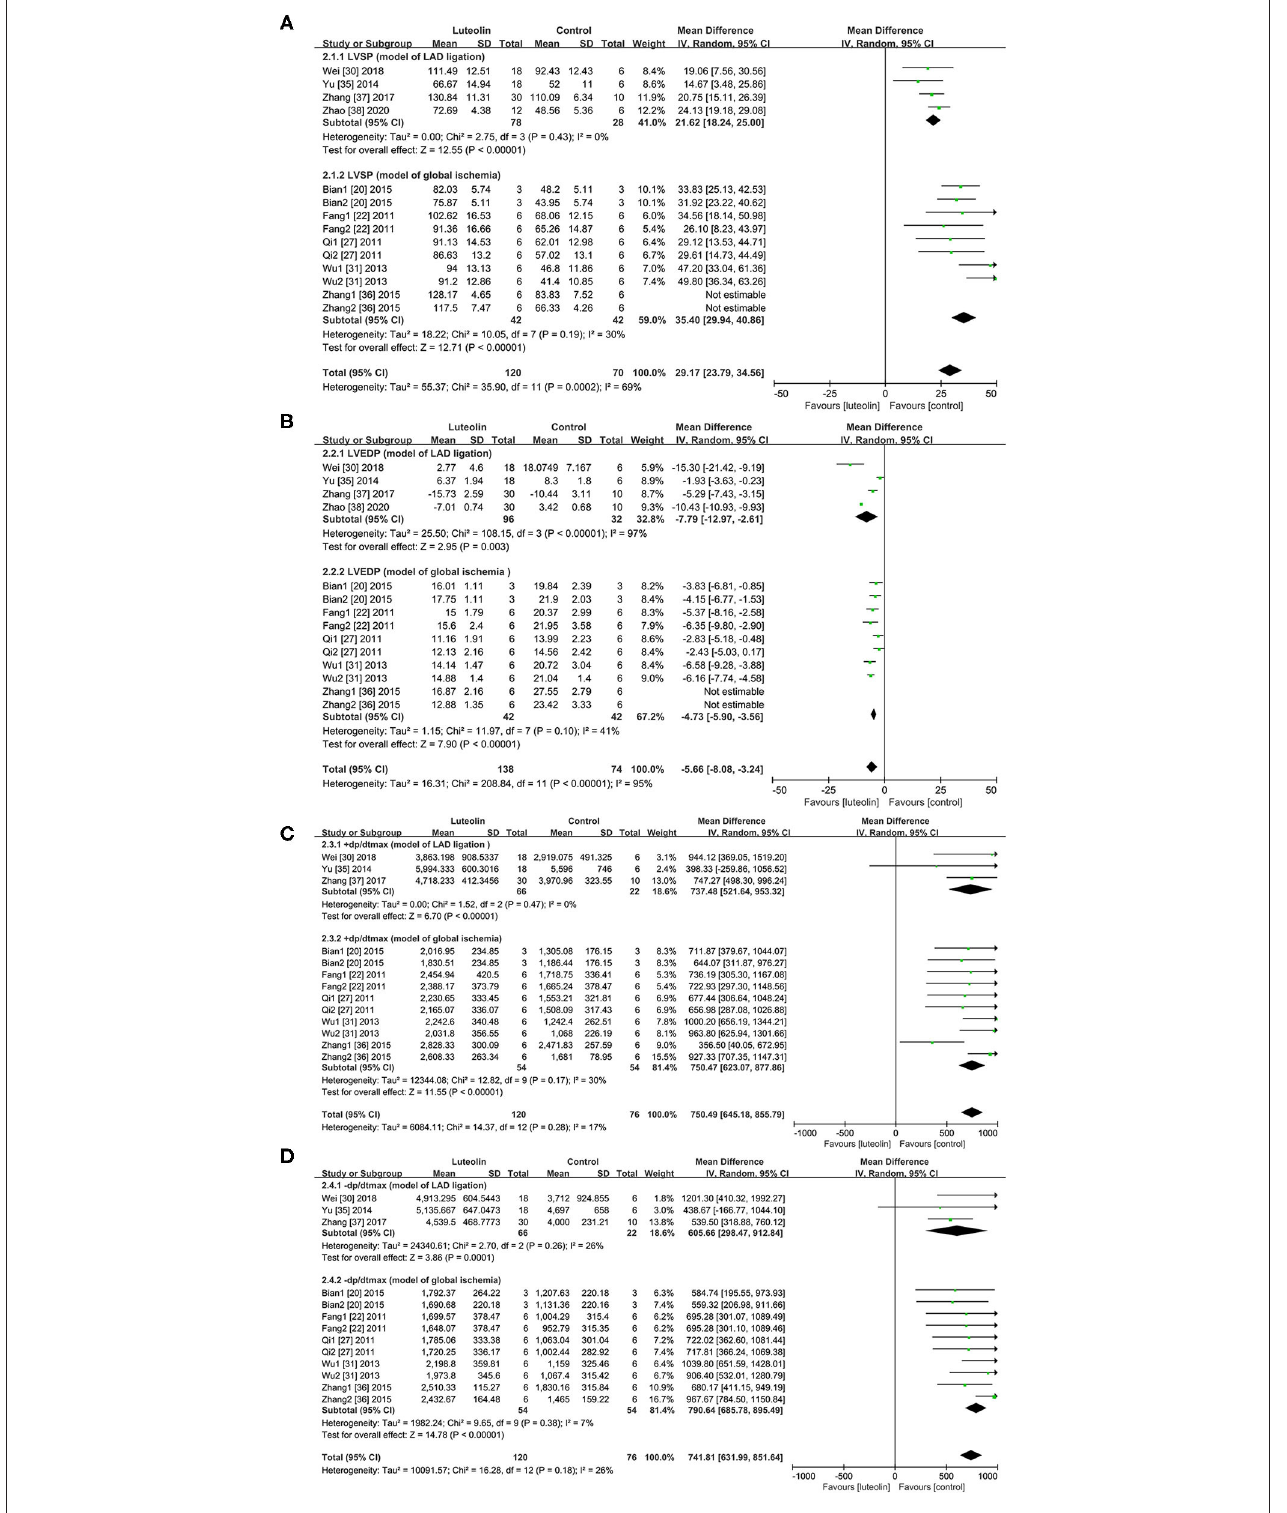
FIGURE 3 | Forest plots for effect of luteolin on hemodynamics including (A) LVSP, (B) LVEDP, (C) + dp/dt max , (D) -dp/dt max . LVSP, left ventricular systolic pressure; LVEDP, left ventricular end-diastolic pressure; + dp/dt max , maximum rate of left ventricular pressure rise; -dp/dt max , maximum rate of left ventricular pressure decrease.